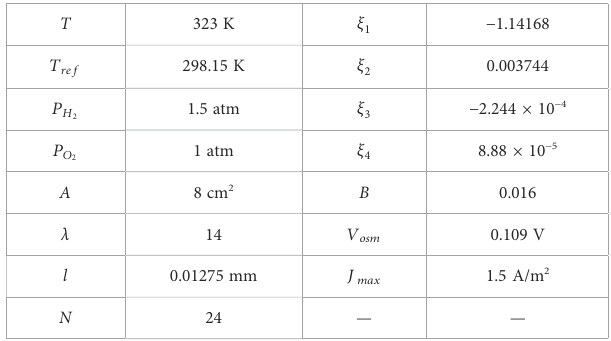
TABLE 2 Parameters used in PEMFC stack model.